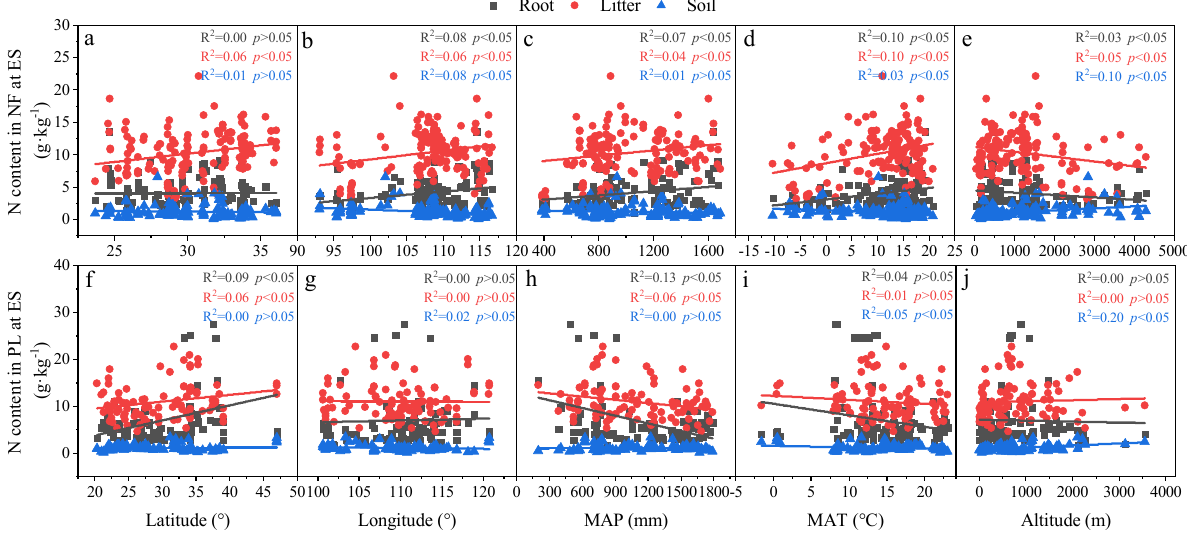
Figure A4. N content changes with latitude ( a , f ), longitude ( b , g ), mean annual precipitation (MAP) ( c , h ), mean annual temperature (MAT) ( d , i ) and altitude ( e , j ) in different forest origins in the early stage (ES). The number of forest sites are 149 and 102 for NF − ES and PL − ES, respectively.